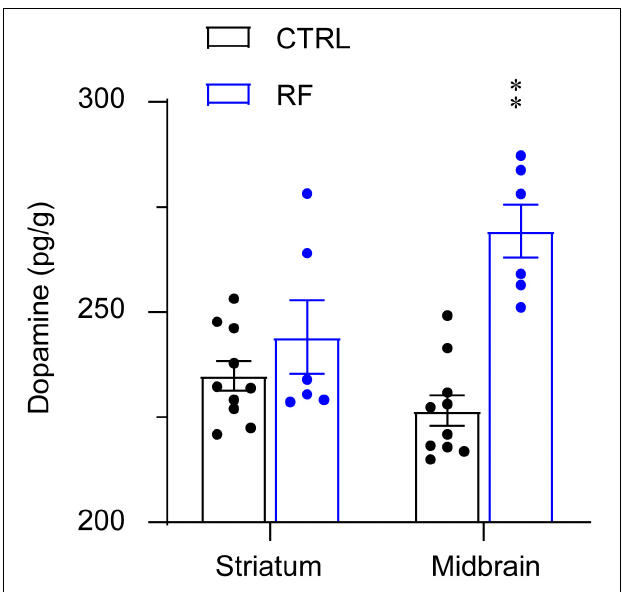
FIGURE 8 | Dopamine concentrations in the striatum and midbrain of the RF and CTRL mice. Dopamine levels in the striatum left panel and midbrain right panel measured by an ELISA. ∗∗ p < 0.01 versus CTRL, n = 6–10. CTRL, control; RF, restricted